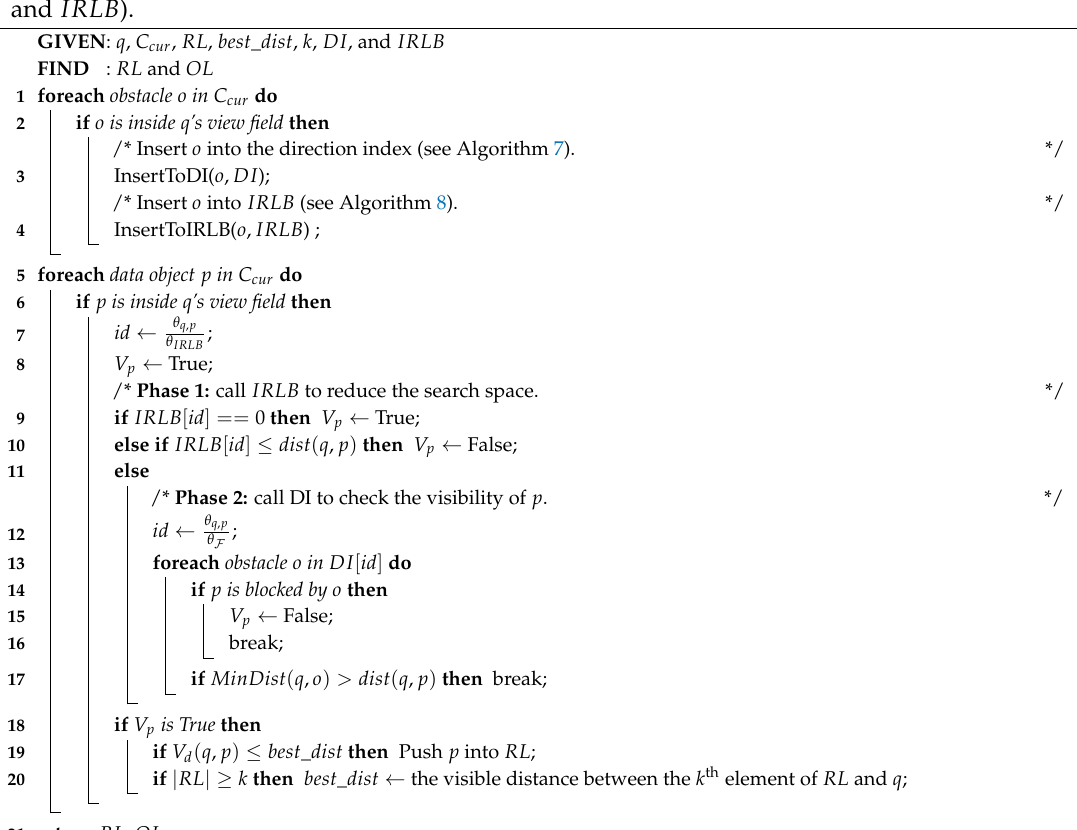
Algorithm 9. Visibility Check Ver. 4 (VC4) Algorithm (visibility check algorithm based on DI and IRLB